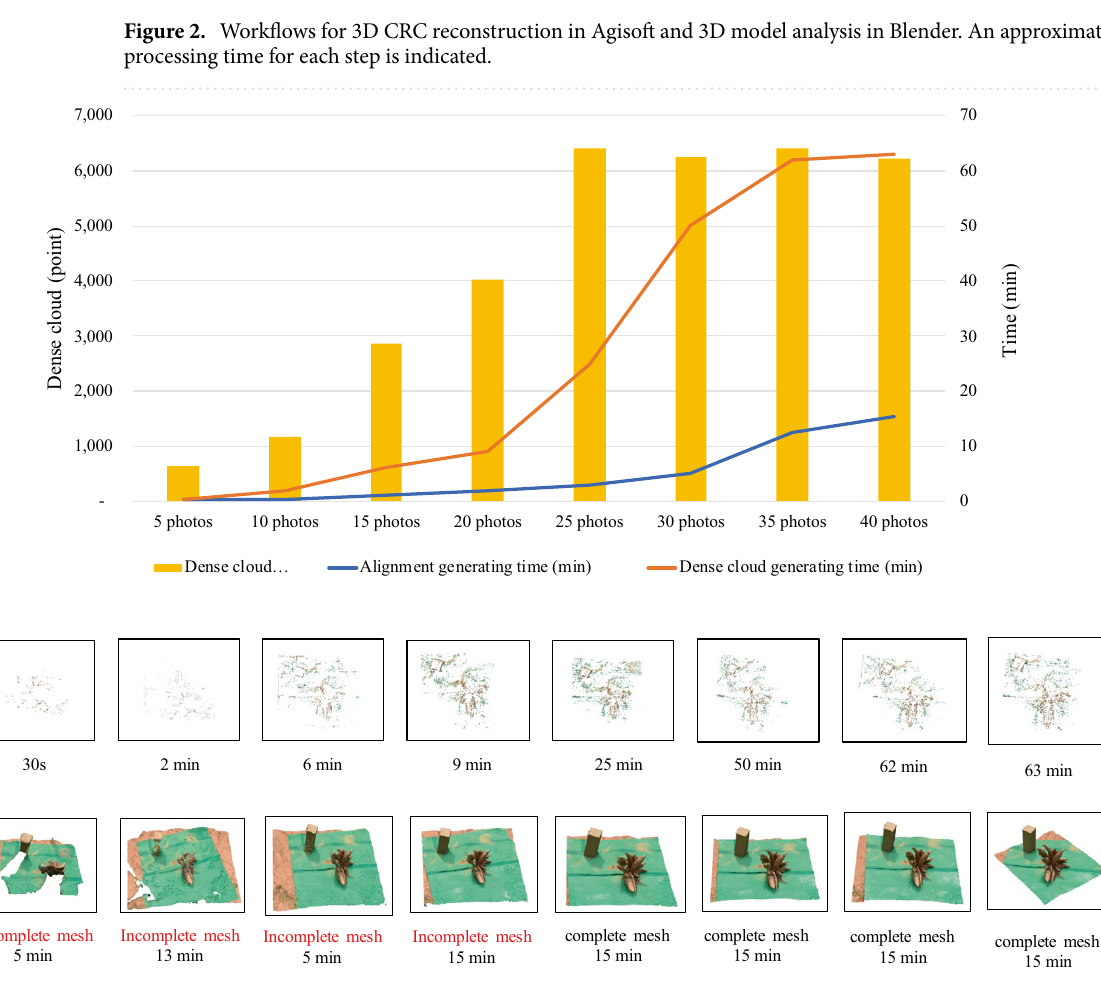
Figure 3. An optimization of the number of images for 3D reconstruction using Agisoft Metashape Standard 1.6.5 (http:// www. agiso ft. com/ downl oads/ insta ller/). The numbers of images (5, 10, 15, 20, 25, 30, 35 and 40) were taken from the same root crown and processed through image alignment, dense cloud generating and mesh generating. Time used each processing step, dense cloud points and mesh qualities are